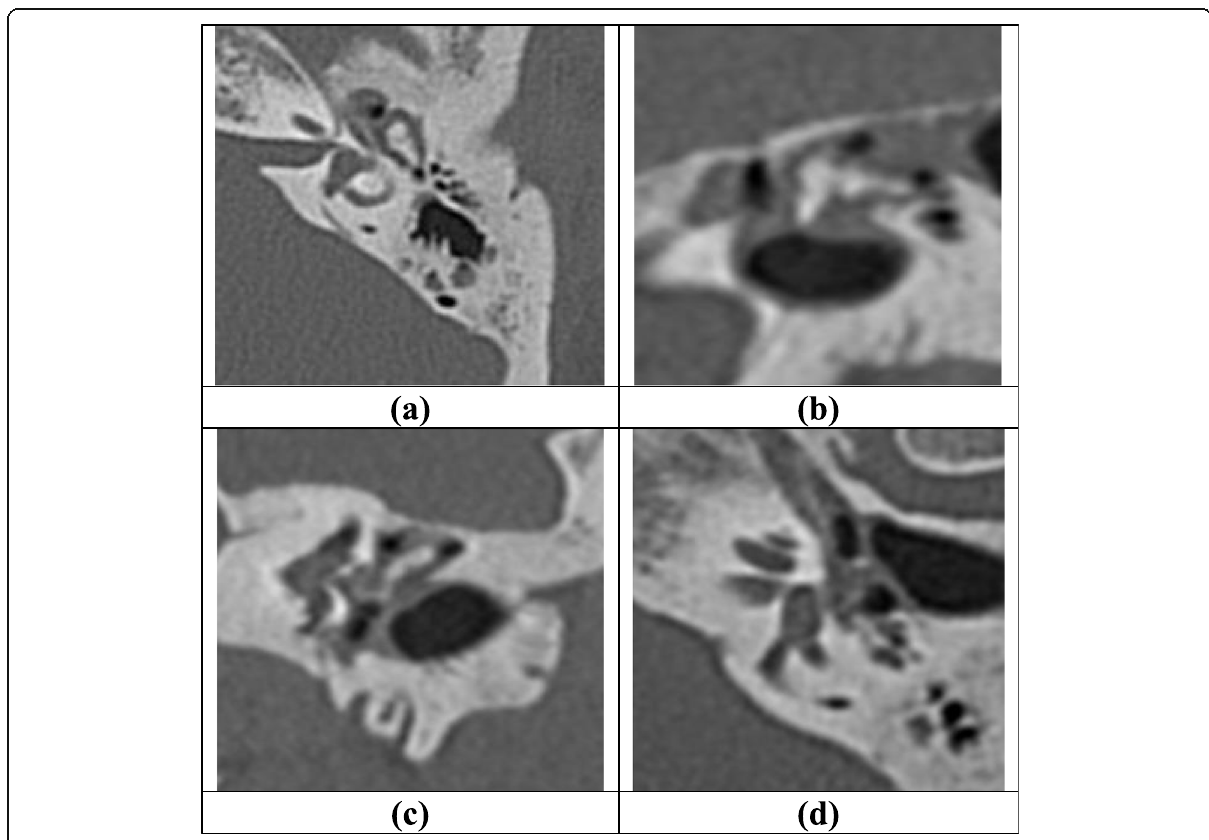
Fig. 4 Case 1: A 32-year-old male with non-cholesteatomatous CSOM, showing type-I cog ( a ) shown as a complete thin bony plate. Reformatted images in ( b ), ( c ), and ( d ) reveal intact ossicular chain; malleus-incus complex in ( b ) and ( c ), and stapedial supra-structure in ( d